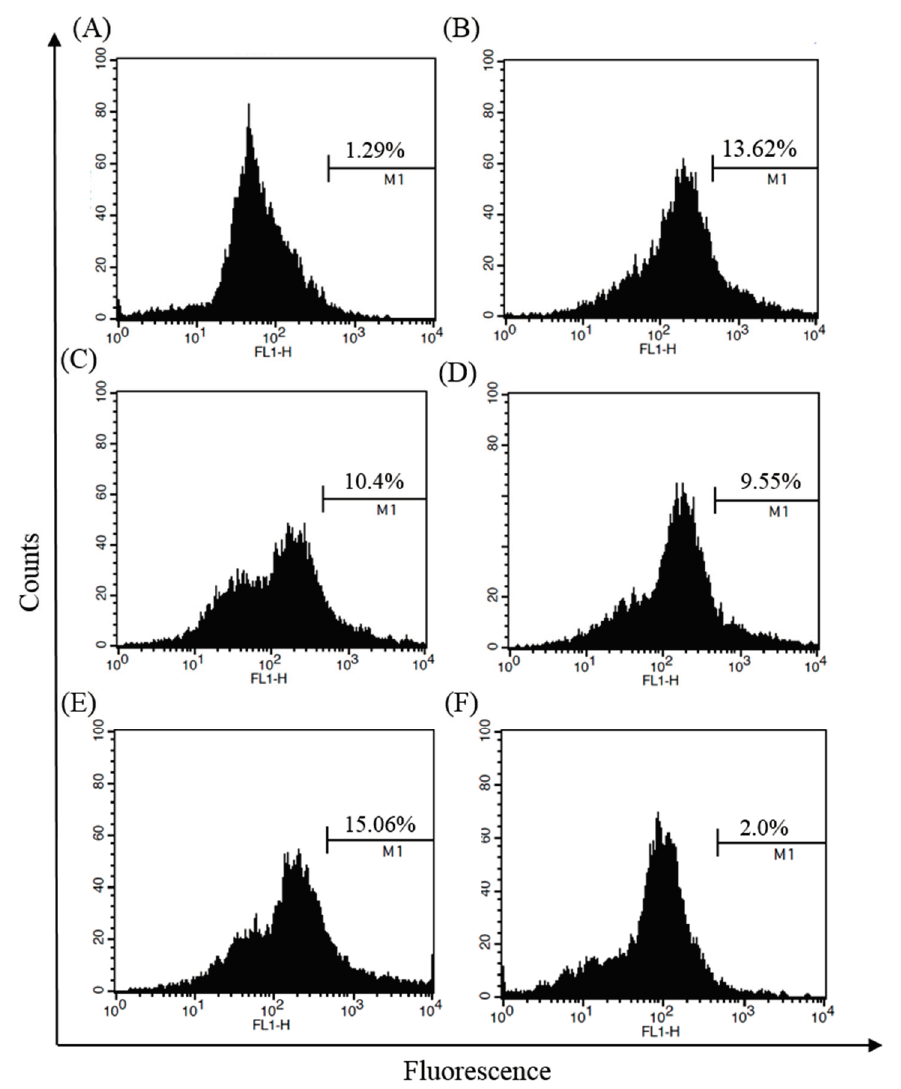
Figure 4. Inhibitory effects of S-LMWCOSs pretreatment on LPS-induced ROS in macrophages. RAW264.7 cells were incubated with control ( A ), LPS ( B ),